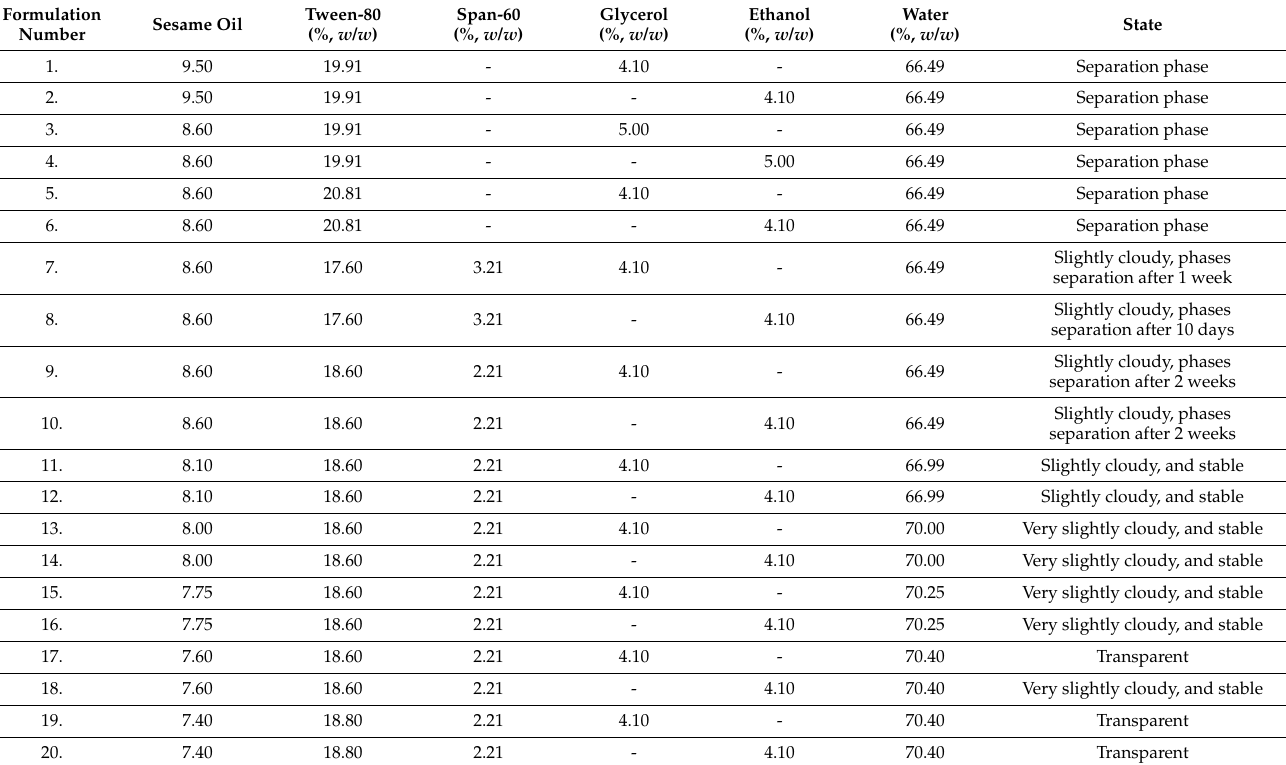
Table 1. Oil, water, surfactants, and co-surfactants constituents’ ratio, and phase states for the